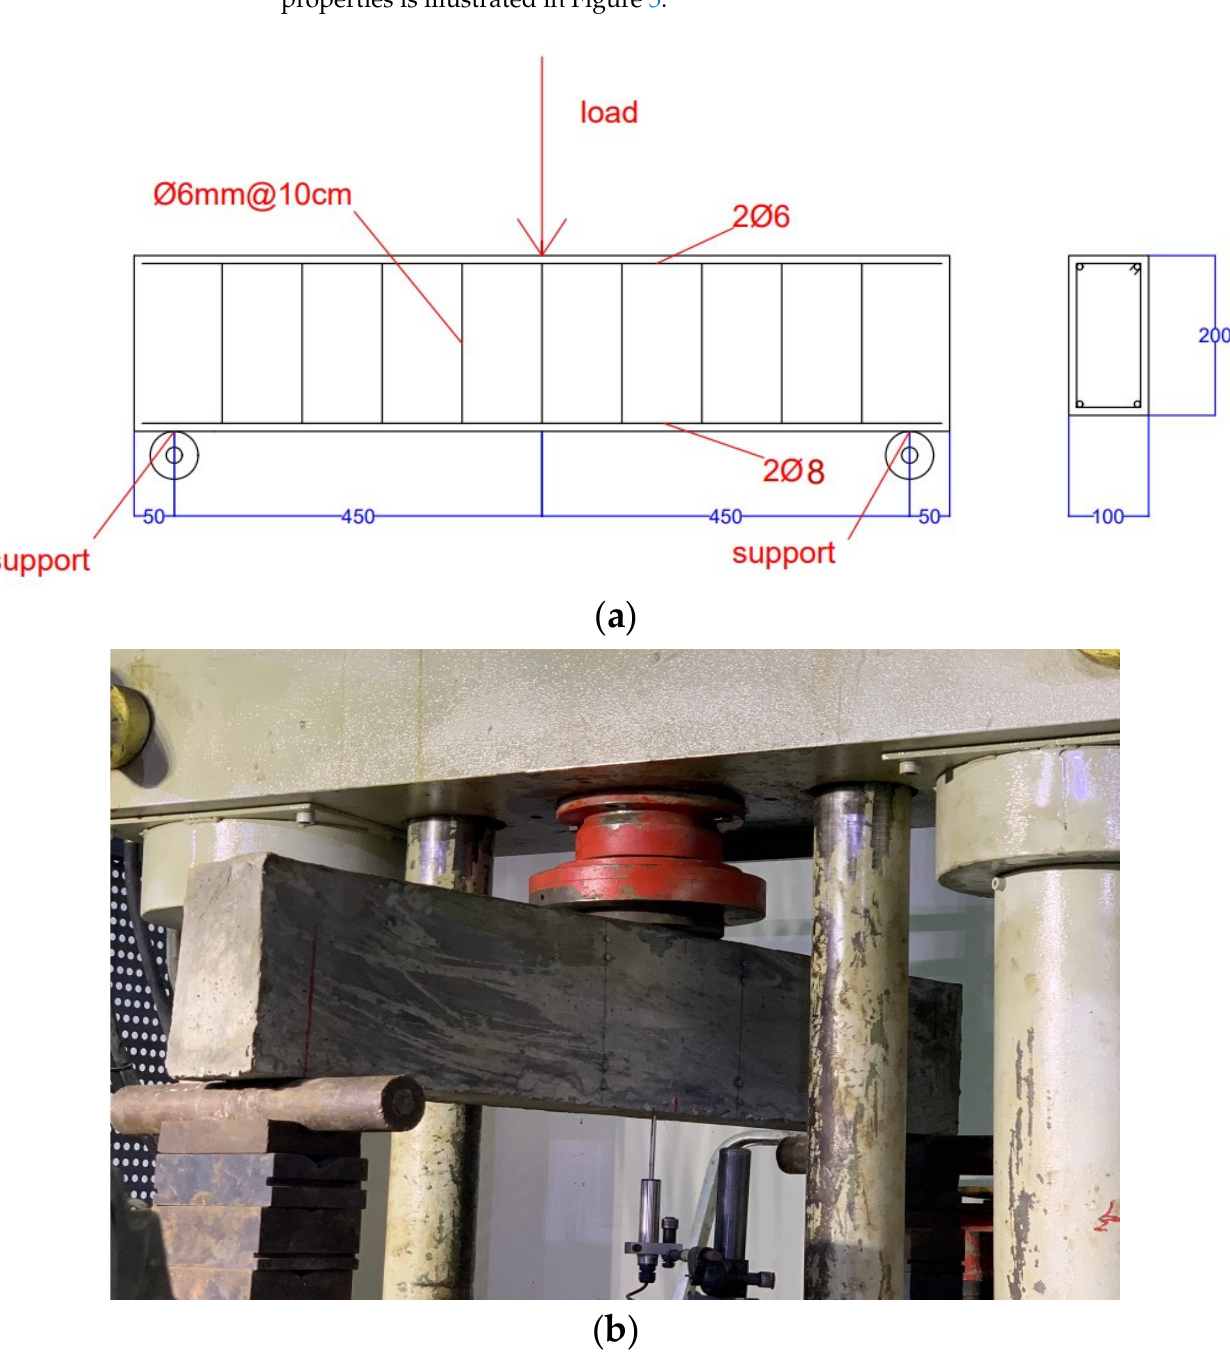
Figure 4. RC beams Testing setup: ( a ) schematic illustration (mm); ( b ) RC beam during testing.